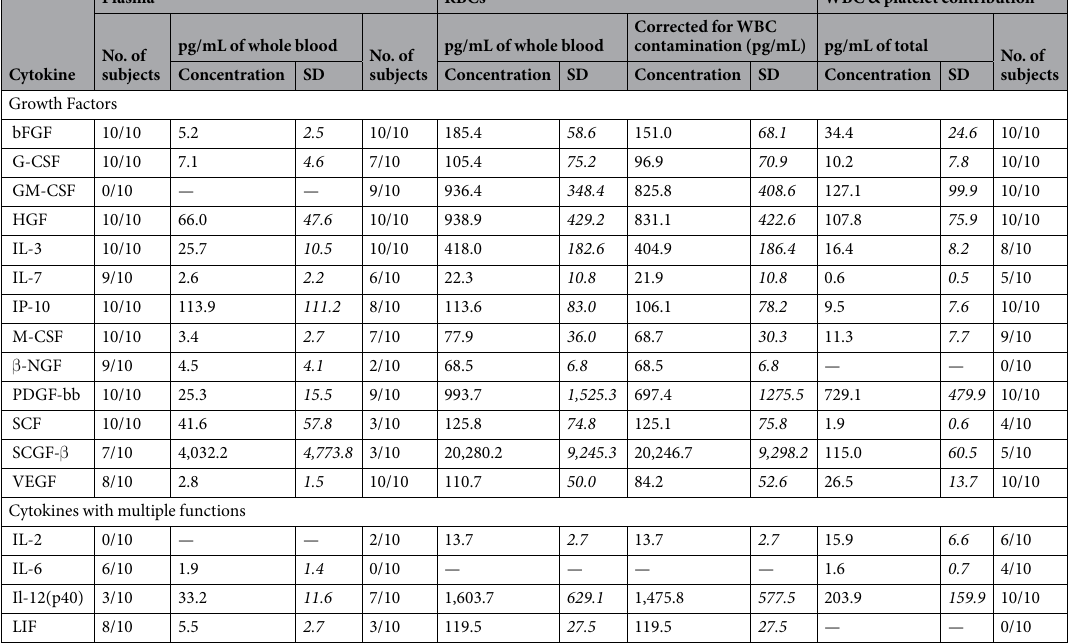
Table 3. Concentration of growth factors and cytokines with multiple functions in EDTA plasma and RBCs in one millilitre of whole blood with correction for white blood cell (WBC) and platelet contamination ( n = 10), data are presented as mean ±